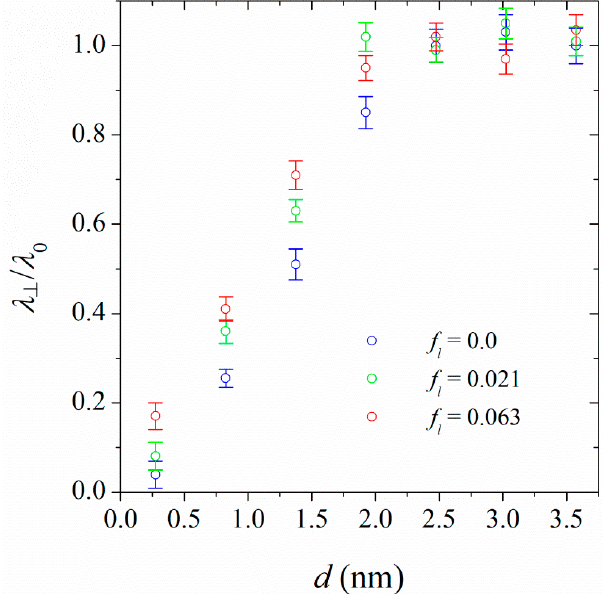
Figure 8. The ratio of perpendicular thermal conductivity, λ ⊥ , of PA-6,6 at the interface of CNT (17, 0) to the thermal conductivity of pure polymer, λ 0 , at three linkage fractions (shown in the figure’s legend). The points at d = 0.275 nm represent interfacial thermal